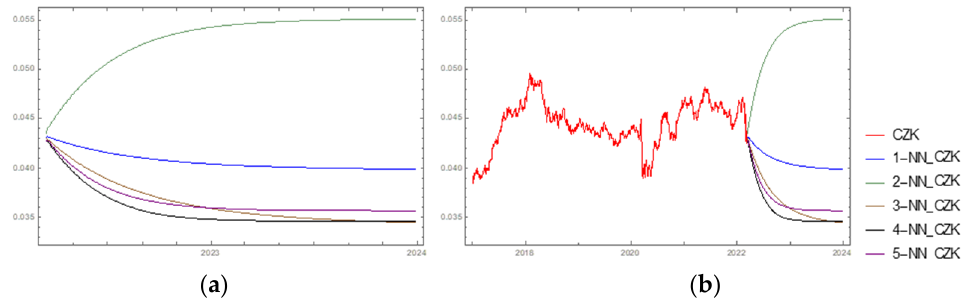
Figure 10. Prediction of the future trend of CZK price until the end of 2023 ( a ) future development of CZK price according to the best neural networks, ( b ) past development of CZK price with its future development according to the best neural networks.